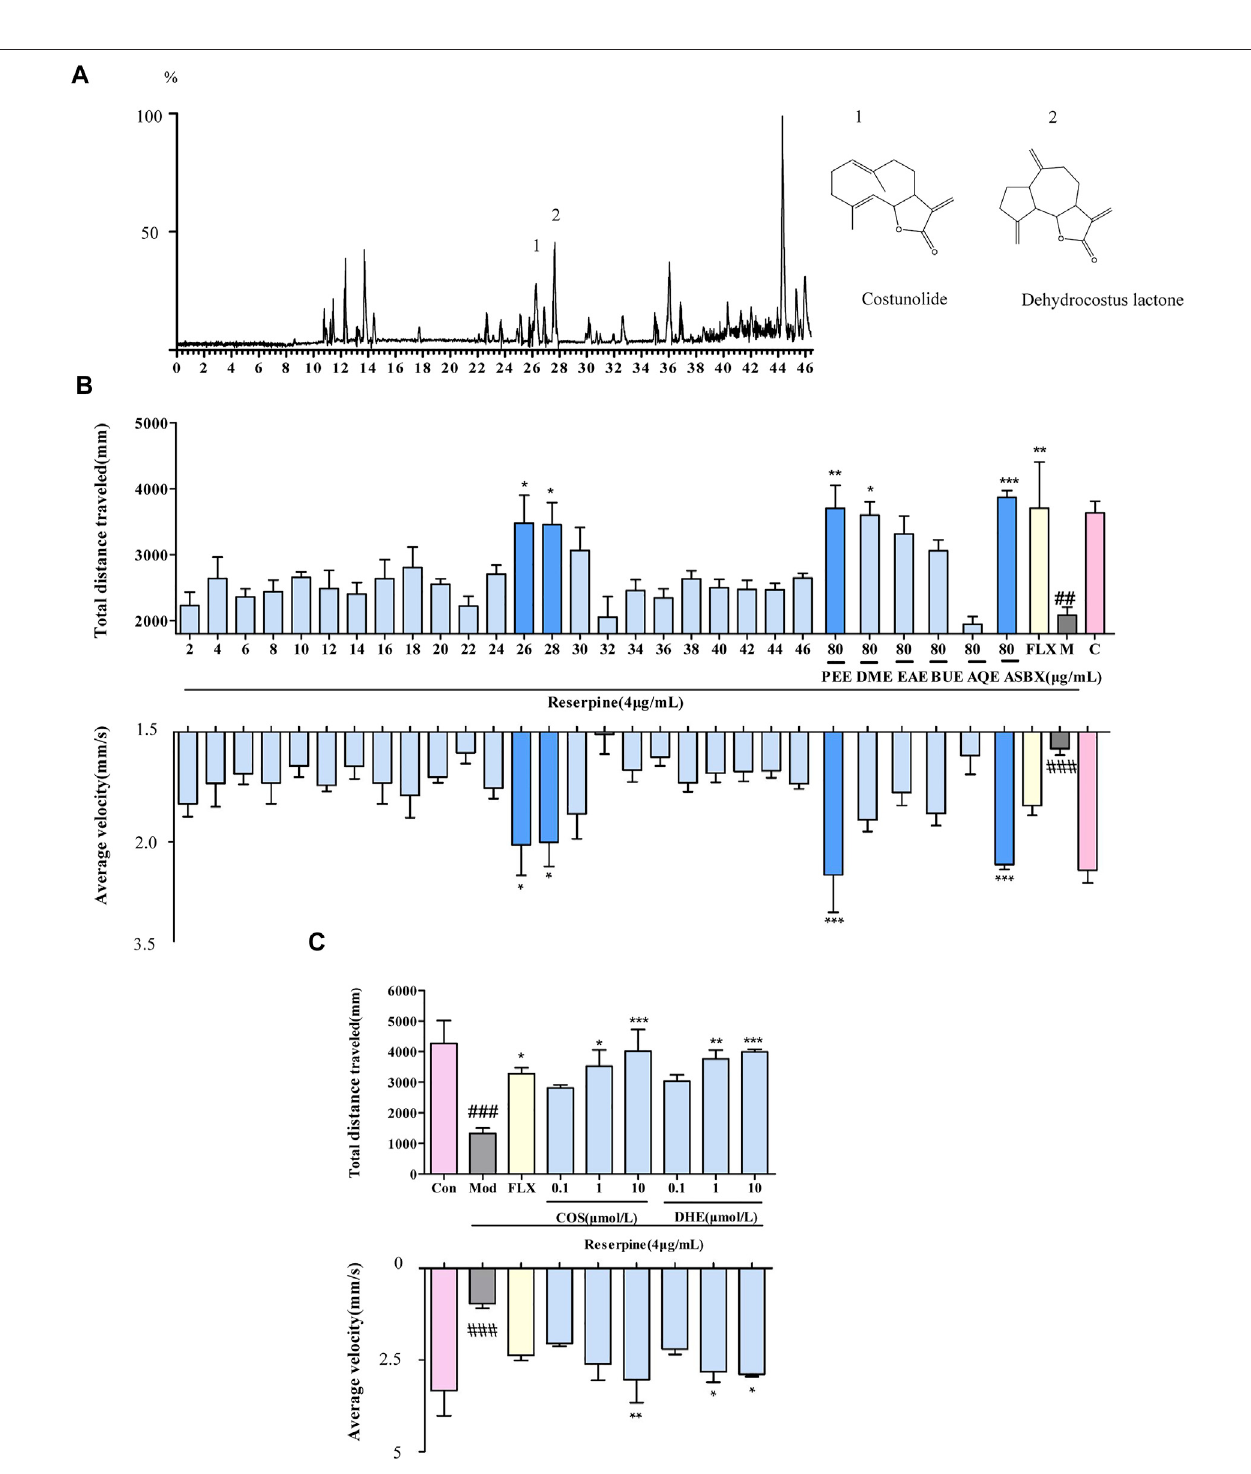
FIGURE 3 | Screening for the antidepressant components of methanolic extract of Anshen Buxin Six Pills (ASBX) on the swimming ability of zebra fi sh larvae. (A) . Total ion chromatograms (TIC) of the petroleum ether extract (PEE) of ASBX in positive ESI mode (B) . Bioactivity histogram obtained via zebra fi sh behavior trajectory analysissystem areanalyzedastotal distance traveled (mm) and averagevelocity (mm/s). (C) .The swimmingbehavior ofcostunolide(COS) and dehydrocostus lactone (DHE) obtained via zebra fi sh behavior trajectory analysis system are analyzed as total distance traveled (mm) and average velocity (mm/s). Data are expressed as the mean ± SEM (n (cid:1) 8/group). Signi fi cance was de fi ned as ## p < 0.01, ### p < 0.001,* p < 0.05, ** p < 0.01, *** p < 0.001.